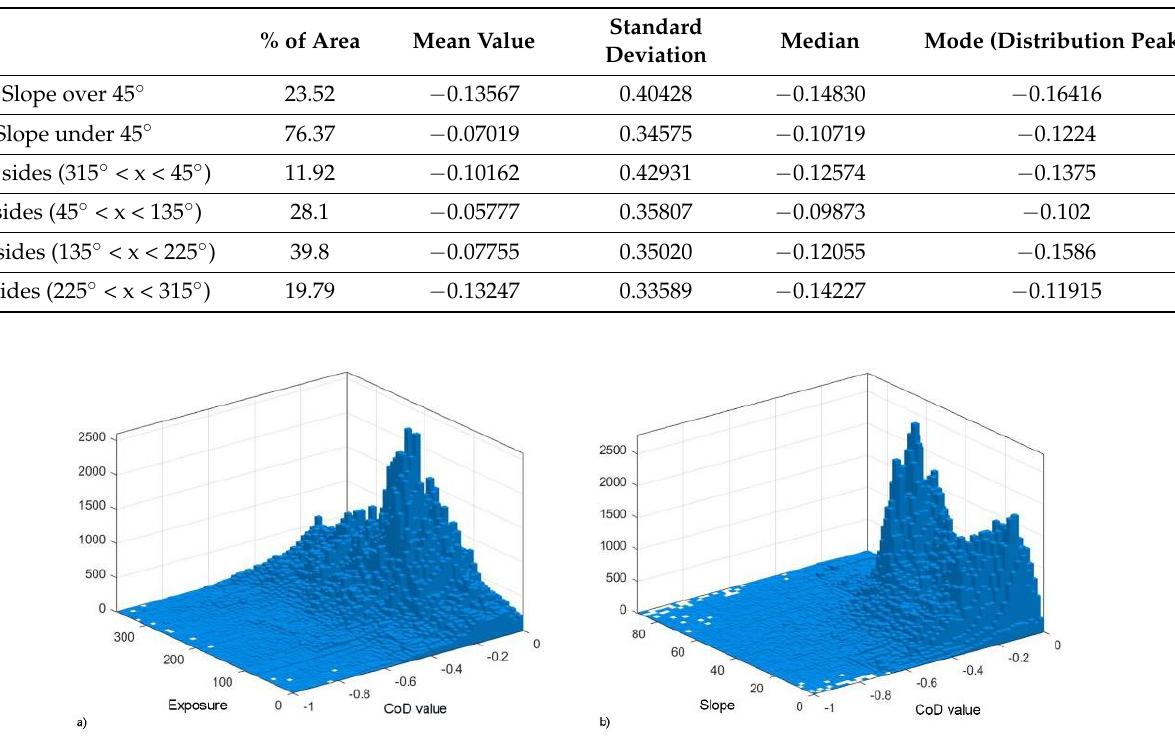
Figure 6. Bivariate histograms calculated by comparing the CoD values with ( a ) the exposures and ( b ) the slope angles; the CoD values ranged between − 1 and 0 metres.